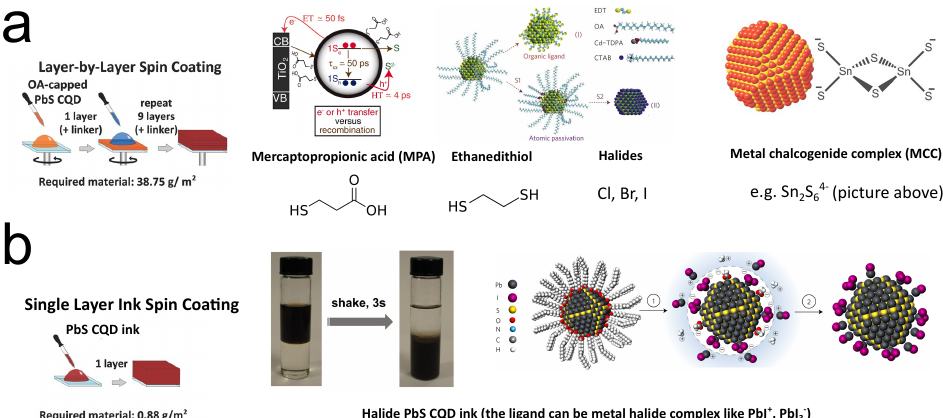
Figure 6. ( a ) Illustration of layer-by-layer ligand exchange. Reprinted with permission from [81,83,86,87]. Copyright 2013 John Wiley & Sons, Inc., 2010 AAAS, 2011 Nature Publishing Group, and 2009 AAAS. ( b ) Illustration of single-layer ink spin coating. Reprinted with permission from [13,86,88]. Copyright 2013 John Wiley & Sons, Inc., 2017 American Chemical Society, and 2017 Nature Publishing